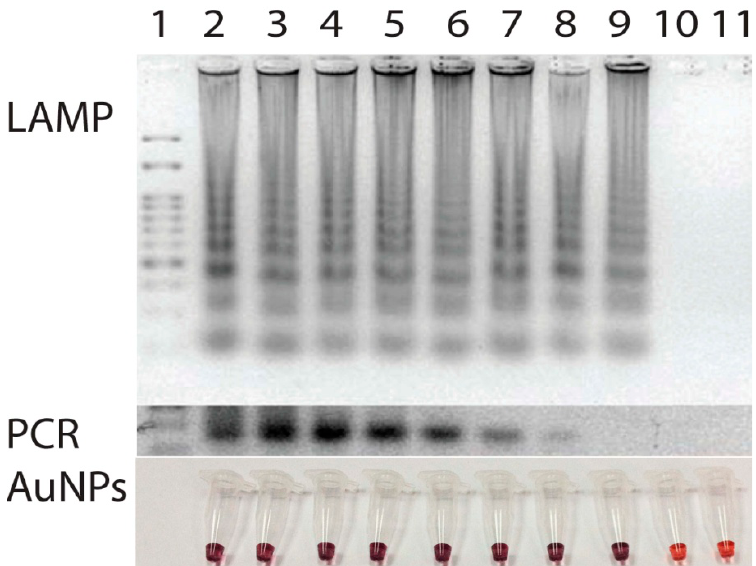
Figure 5. Sensitivities of LAMP amplification and gold nanoparticles detection. Lane 1, 100 bp ladder; Lane 2, Positive control; Lane 3–8, serial dilution of E. canis DNA template 10 8 to 10 2 copies; Lane 9 and 10, serial dilution of E. canis DNA template at 50 and 0 copy; Lane 11, Non template control. LAMP amplification had a limit of detection at 50 copies of p30